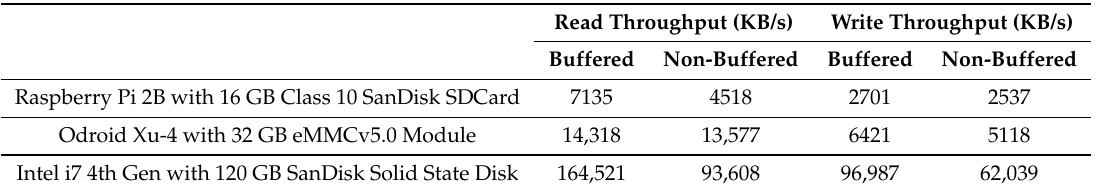
Table 5. Read and write throughput (KB/s) for individual devices in the clusters using FIO. Read Throughput (KB/s) Write Throughput (KB/s) Buffered Non-Buffered Buffered Non-Buffered Raspberry Pi 2B with 16 GB Class 10 SanDisk